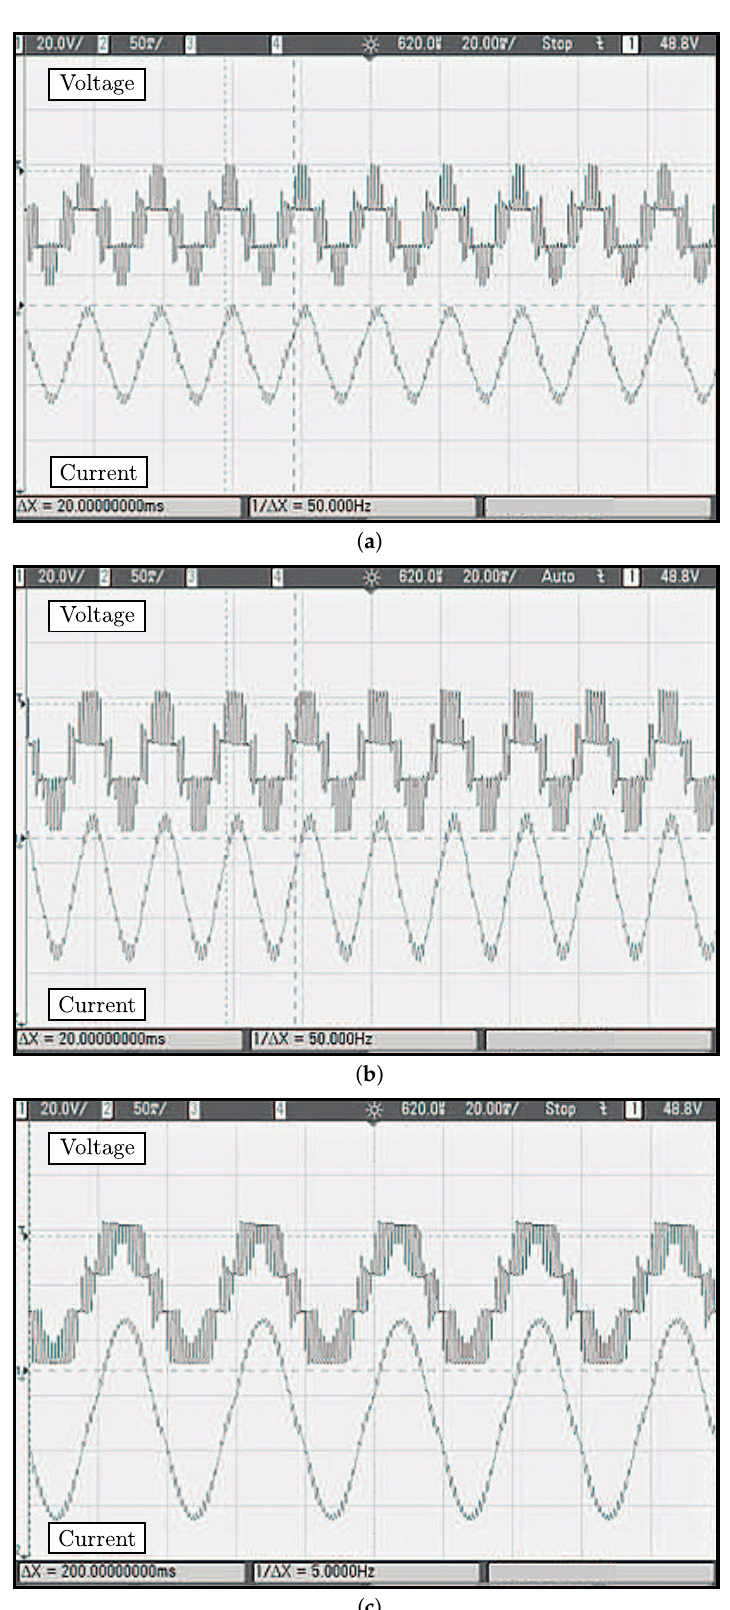
Figure 13. Experimental results for voltage and current waveforms with modulation index ( a ) m = 0.5, ( b ) m = 0.8 and ( c ) m =